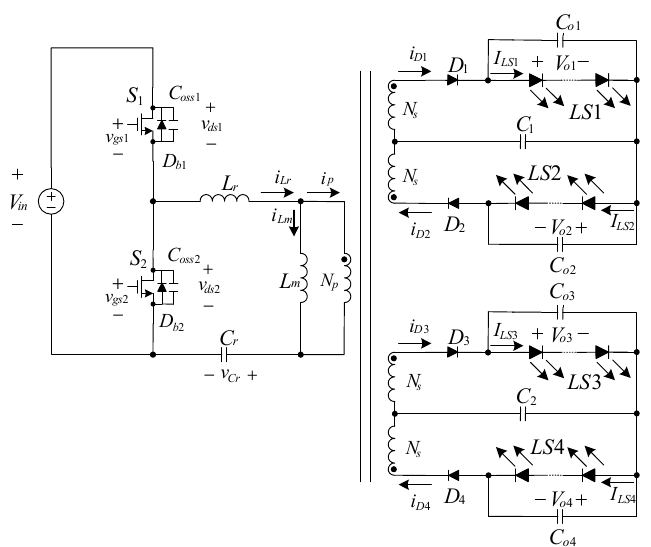
Figure 11. Four-channel LED driver derived from the proposed LED driver.